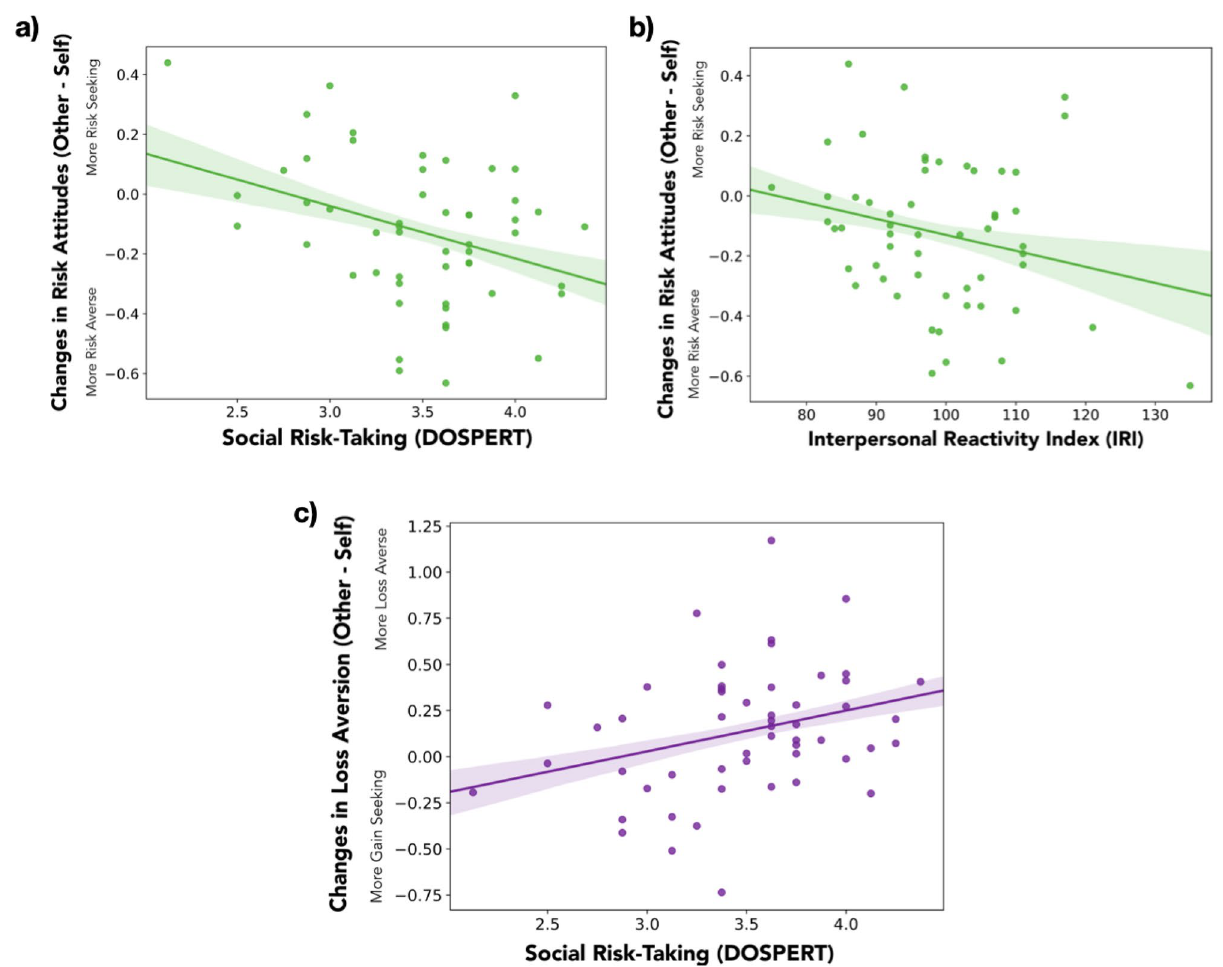
Figure 4. Sensitivity to social context in risky decision-making relates to social cognition and social risk perception. Exploratory analyses revealed associations between subject-level estimates of changes in both risk attitudes and loss aversion (see details for Model 2 in main text) as a function of the ‘other’ term and the self-reported tendency to make socially risky decisions ( a , c ; p ’s < .05) and a composite measure of empathy ( b ; p = .